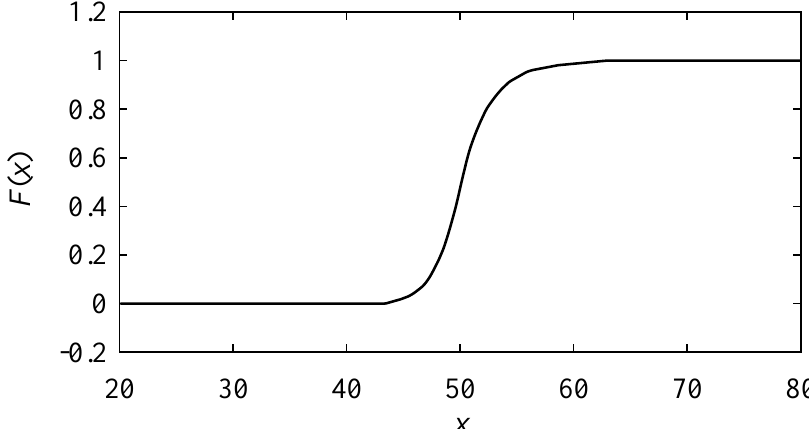
Figure A8. Nature of cumulative probability distribution of a point-cloud.